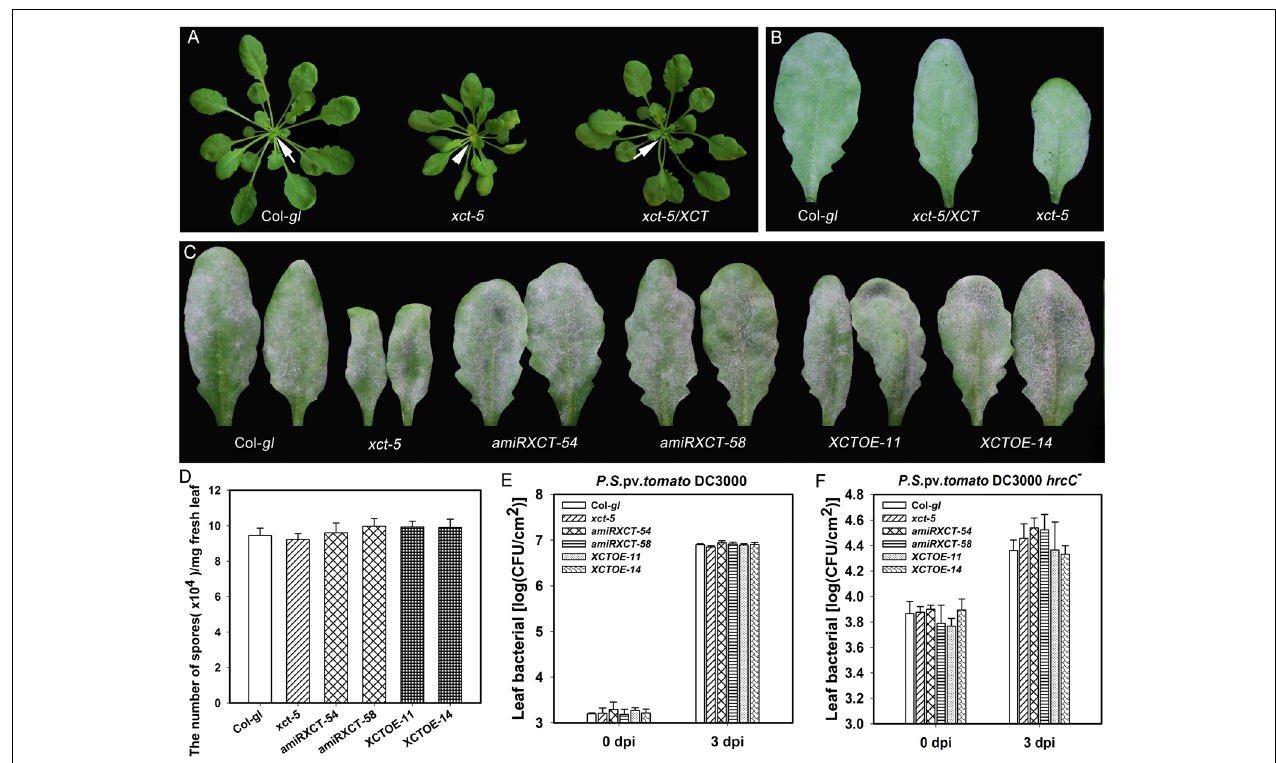
FIGURE 8 | Mutation, knocking-down and overexpressing of XCT in Col- gl do not change disease phenotypes. (A,B) Representative plants (A) and powdery mildew infected-leaves (B) of the indicated lines show the morphology and disease phenotype, respectively. Note the freshly emerged light-green leaves in xct-5 (arrowheads) in comparison with those in Col- gl and the complemented line xct-5 / XCT (arrow). (C) Representative leaves from the indicated lines show the disease phenotype of powdery mildew at 10 dpi. (D) Quantification of sporulation at 10 dpi. Error bars represent SD ( n = 6). (E,F) Growth of the virulent strain P. syringae DC3000 (E) and the non-pathogenic mutant strain P. syringae DC3000 ( hrcC - ) (F) in the indicated lines. Error bars indicate SD ( n = 6). Similar results were obtained in three independent